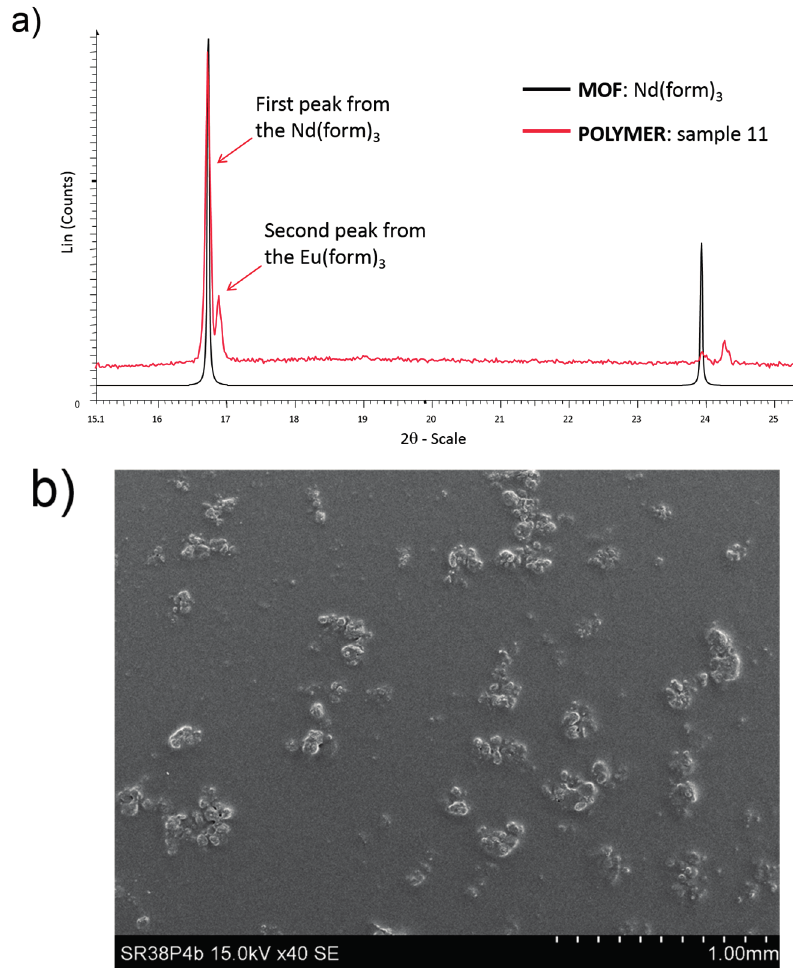
Figure 5. ( a ) The PXRD diagram of polymer sample 11 showing MOF residues of Nd(form) 3 and Eu(form) 3 ; ( b ) The SEM image of sample isolated from run 11 showing dispersed MOF